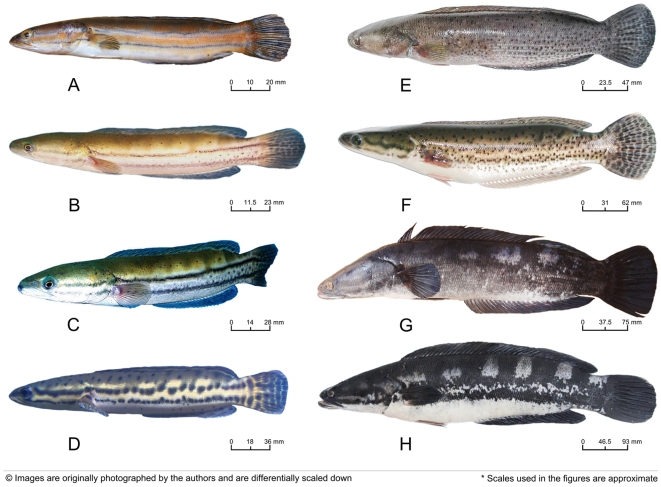
Ontogenetic color phases of Channa diplogramma.
A: Fingerling; B: Fingerling, C: Juvenile, D: Juvenile, E: Sub-Adult, F: Sub-Adult, G: Adult, H: Adult (length in millimeters is given as a scale below each specimen); all individuals were collected from the river Meenachil in Kerala, India.